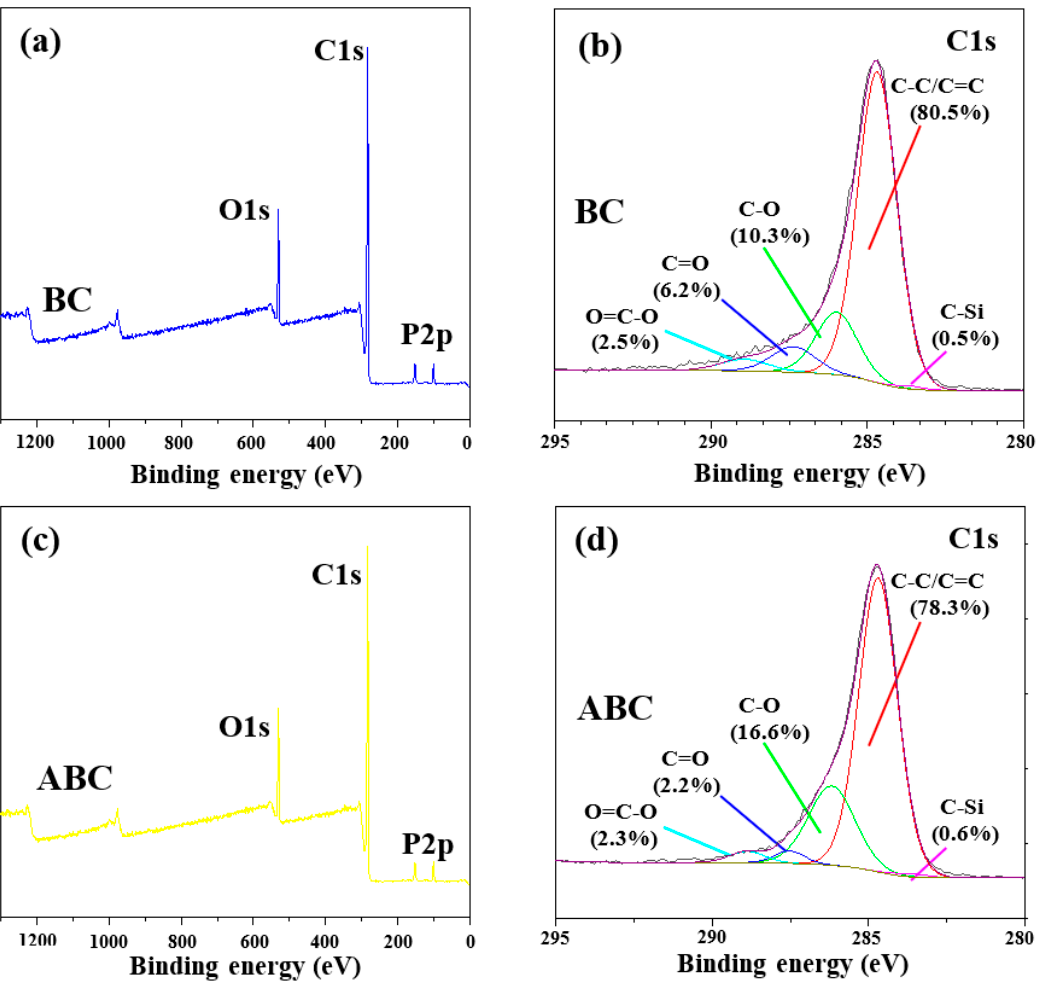
Figure 2. The full spectra ( a , c ) and high-resolution XPS spectra of C1s ( b , d ) of the biochar and acid-modified biochar.